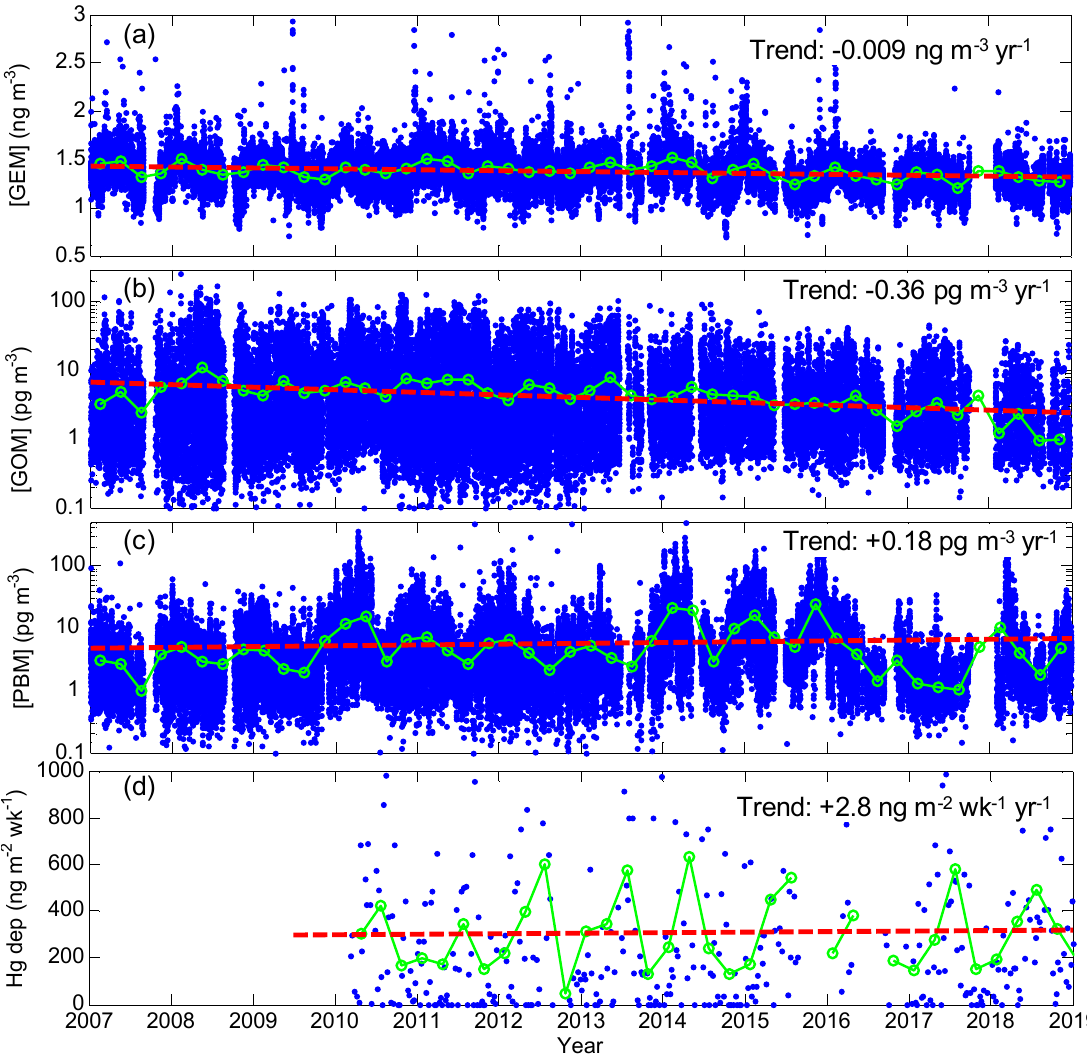
Figure 4. Time series of GEM ( a ), GOM ( b ), PBM ( c ), and mercury wet deposition ( d ) measured at the Grand Bay site from 2007 to 2018. The individual points show hourly averaged atmospheric mercury concentrations in ( a–c ) and Hg wet deposition in weekly samples in ( d ). The linked green circles are quarterly mean mercury concentrations and Hg wet deposition. The red dashed lines represent linear regressions of the quarterly means over 2007–2018. The GEM and GOM trends are statistically significant ( p -value < 0.01) but the PBM and Hg wet deposition trends are not ( p -value > 0.01).